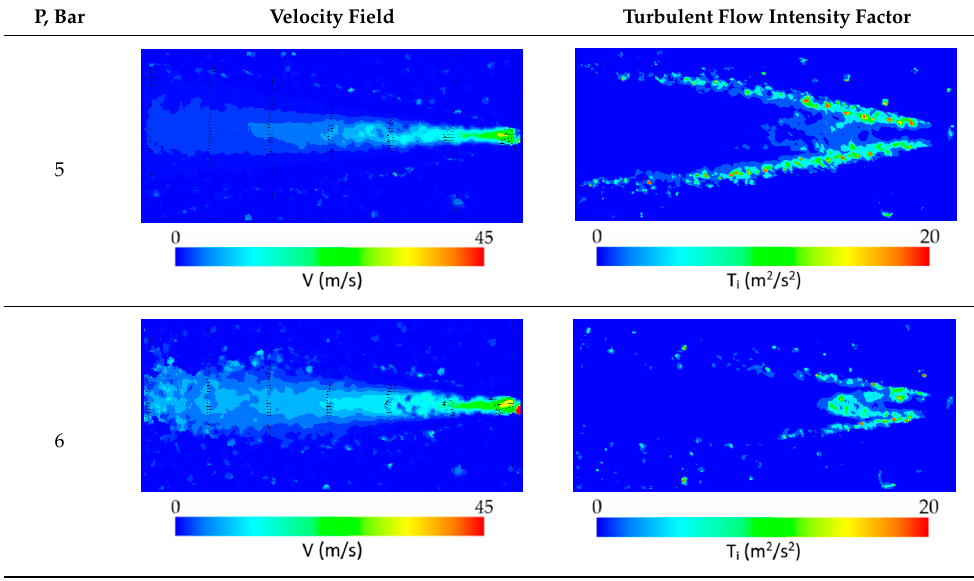
Table 3. Influence of pressure P supplying the nozzle on the character of velocity and turbulent flow intensity factor fields for stub regulation angle α = − 45°. P, Bar